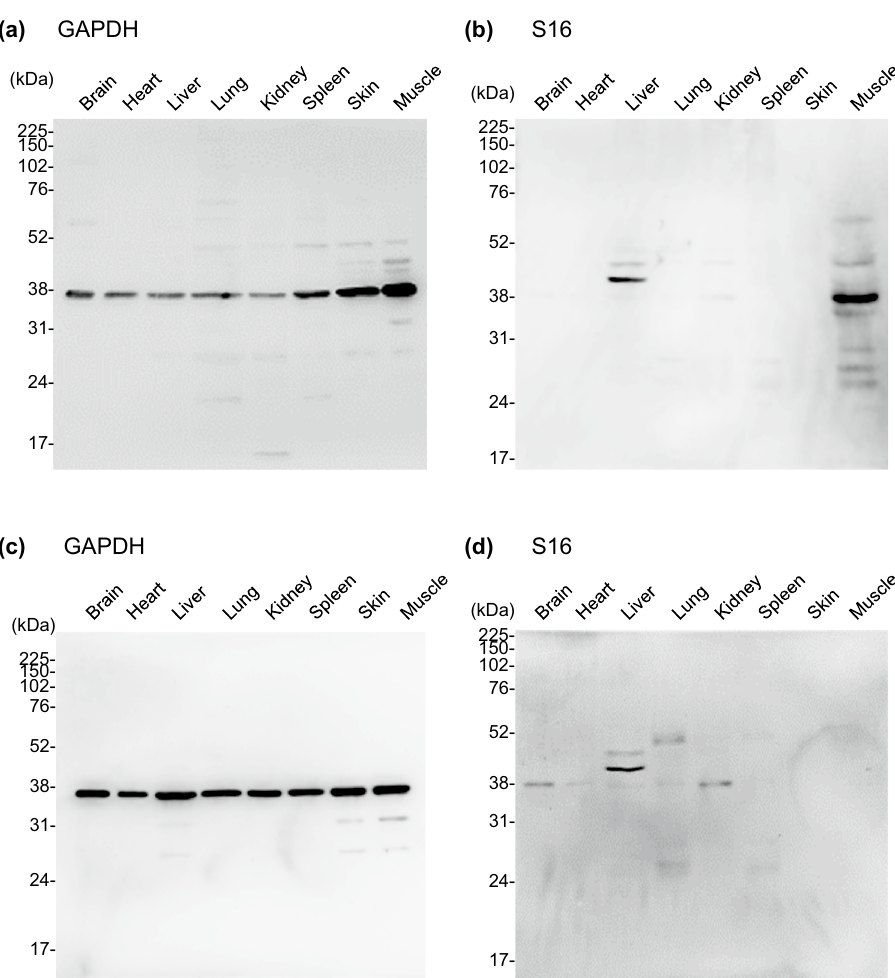
Figure 2. Organ distribution of S16-binding protein. Organs (brain, heart, liver, lung, kidney, spleen, skin, and muscle) were harvested from two different BALB/c mice (7-week-old, female). Upper and lower images refer to individual mice: mouse 1 ( a,b ) and mouse 2 ( c,d ). The proteins extracted from the organs (3 μg) were separated on a 12% SDS-PAGE, followed by western blotting with α-mouse GAPDH mAb ( a,c ) or S16 ( b,d ). Molecular weight markers are shown at the left of the gels